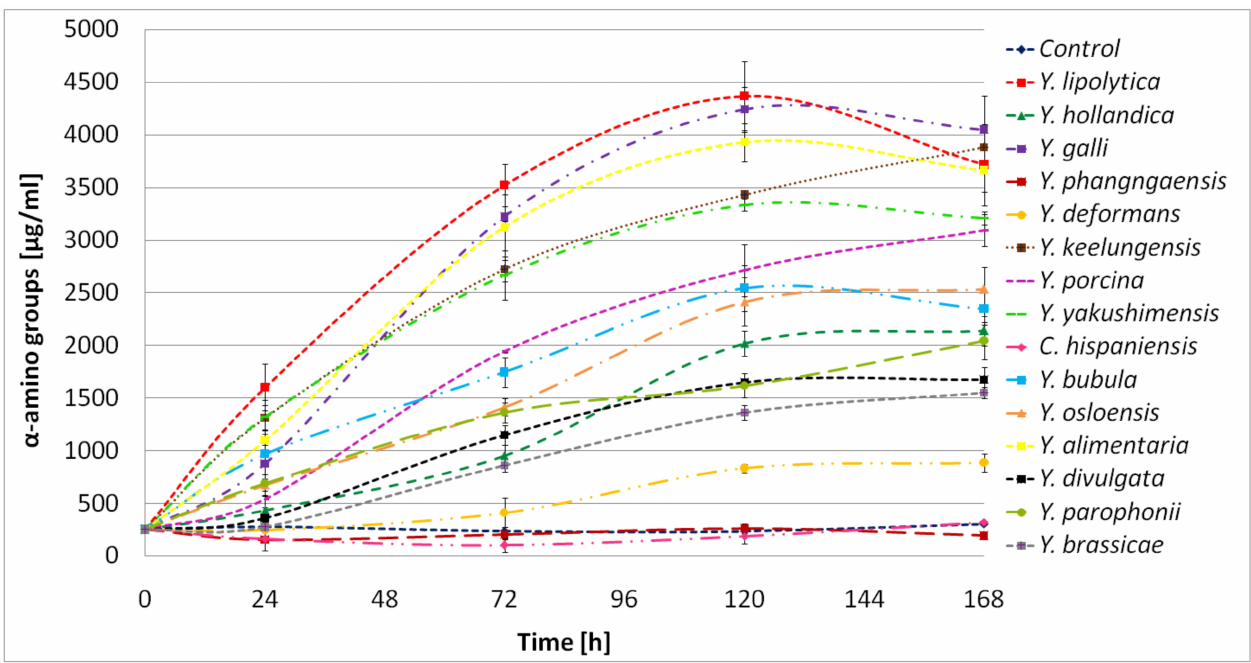
Figure 6. Free α -amino groups concentration in Yarrowia clade cultures grown in BSG protein medium as a function of time. The results are presented as mean values ± SD. n =